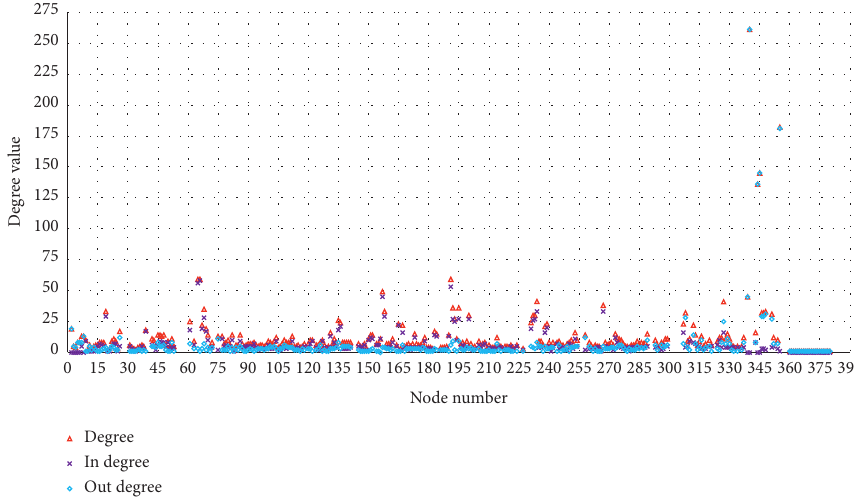
Figure 4: Node degree in the PNSRTP.